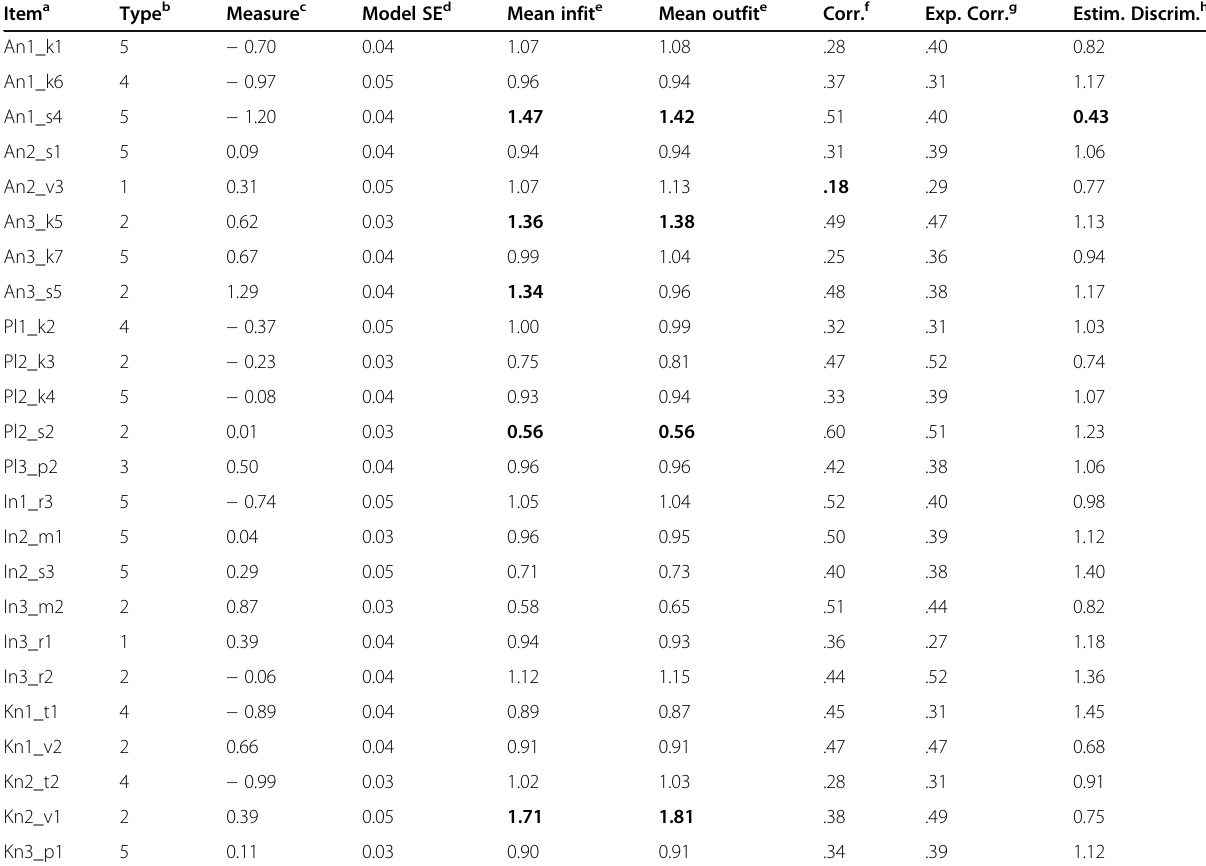
Table 4 Indices of the quality of SIT-PE items evaluated based on the 1PL IRT analysis Item